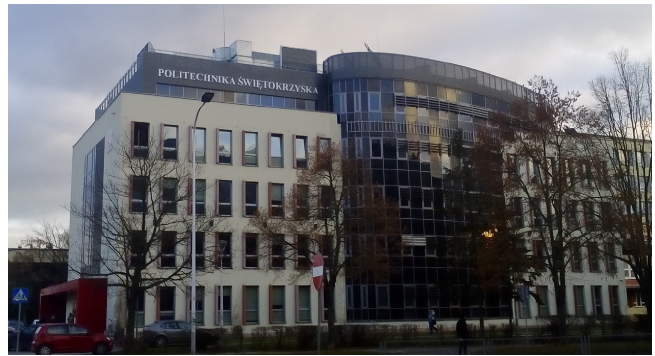
Figure 1. “Energis” building of Kielce University of Technology (Western façade).